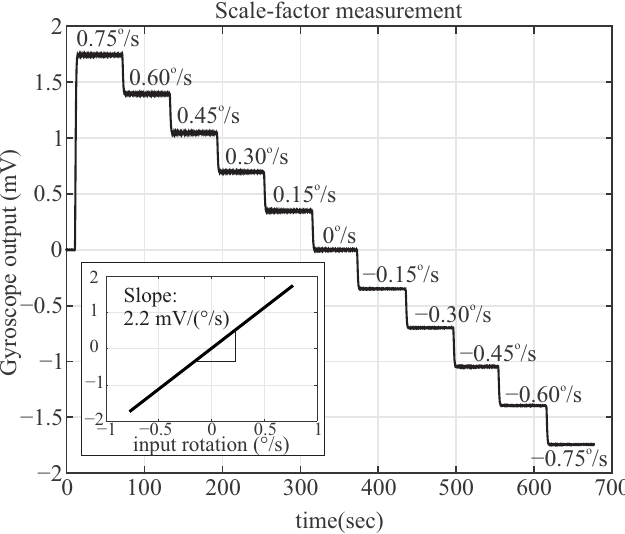
Figure 15. Characterization of angular rate response to clockwise and counter-clockwise rotation with different step-input amplitudes of 0, ± 0.15, ± 0.30, ± 0.45, ± 0.60 and ± 0.75 °/s, revealing an open-loop scale-factor of 2.2mV/ ( °/s )